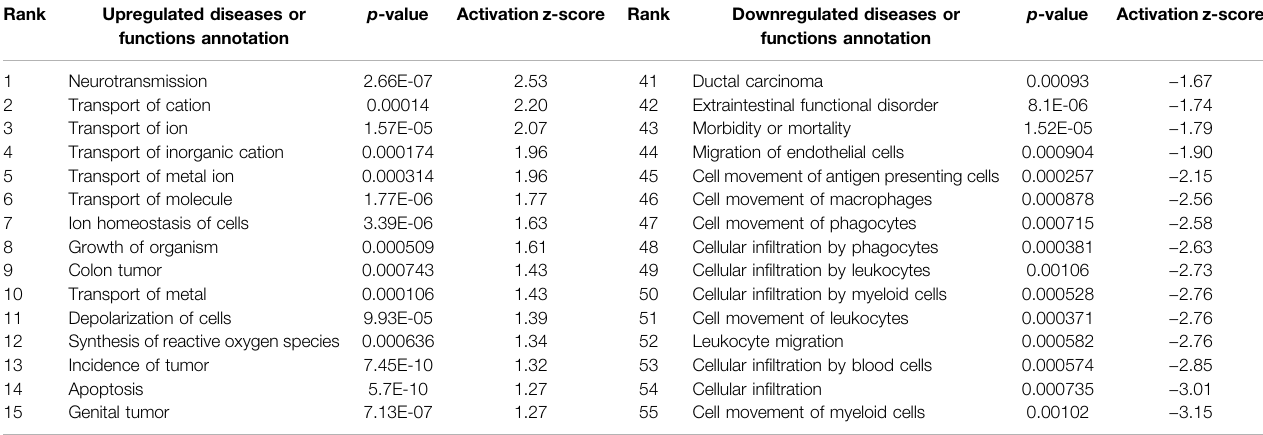
TABLE 8 | Ingenuity Pathway Analysis table of disease or Functions from TBxCB DEGs ( p < 0.01, log fold change > 1/ < − 1). From “ Diseases or Functions Annotations ” column, after removing any redundancies, functions without a z-score, or a z-score between − 1 and 1. Mapped IDs: 9,868/unmapped IDs: 4,924 (raw data), after settings of log fold change > 1 or < − 1, p < 0.01.206 analysis-ready molecules: 114 upregulated and 92 downregulated. Ranked by z-score. Left: upregulated pathways. Right: downregulated